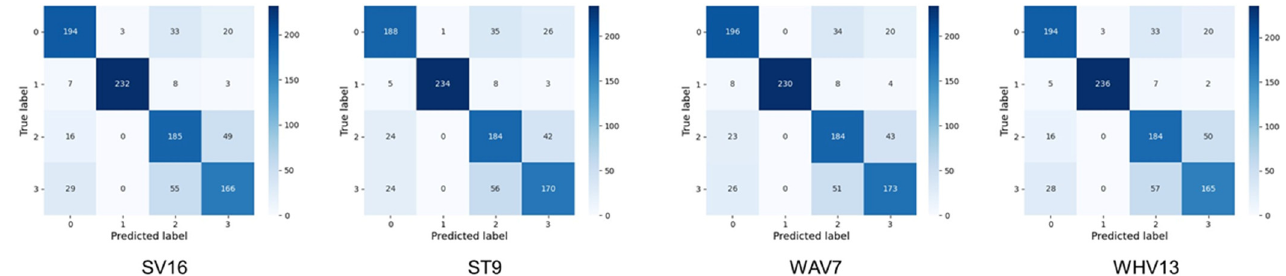
Figure 7. Four-class confusion matrix of the models with the highest accuracy by pruning in each of the four types of ensemble learning. The classes indicated by the numbers of the labels on the x- and y-axes of each confusion matrix are as follows. 0: Benign Liver Tumor, 1: Liver Cyst, 2: Metastatic Liver Cancer, 3: Primary Liver Cancer, SV16: top16 was used for soft voting, ST9: top9 was used for stacking, WAV7: top7 was used for weighted average voting, WHV13: top13 was used for weighted hard voting. Table 7. True positive, false positive, false negative, and true negative values for 4-class classification in the models with the highest accuracy by pruning in each of the four types of ensemble learning. BLT: benign liver tumor, LCY: liver cyst, MLC: metastatic liver cancer, PLC: primary liver cancer, TP: true positive, FP: false positive, FN: false negative, TN: true negative, SV16: top16 was used for soft voting, ST9: top9 was used for stacking, WAV7: top7 was used for weighted average voting, WHV13: top13 was used for weighted hard voting.